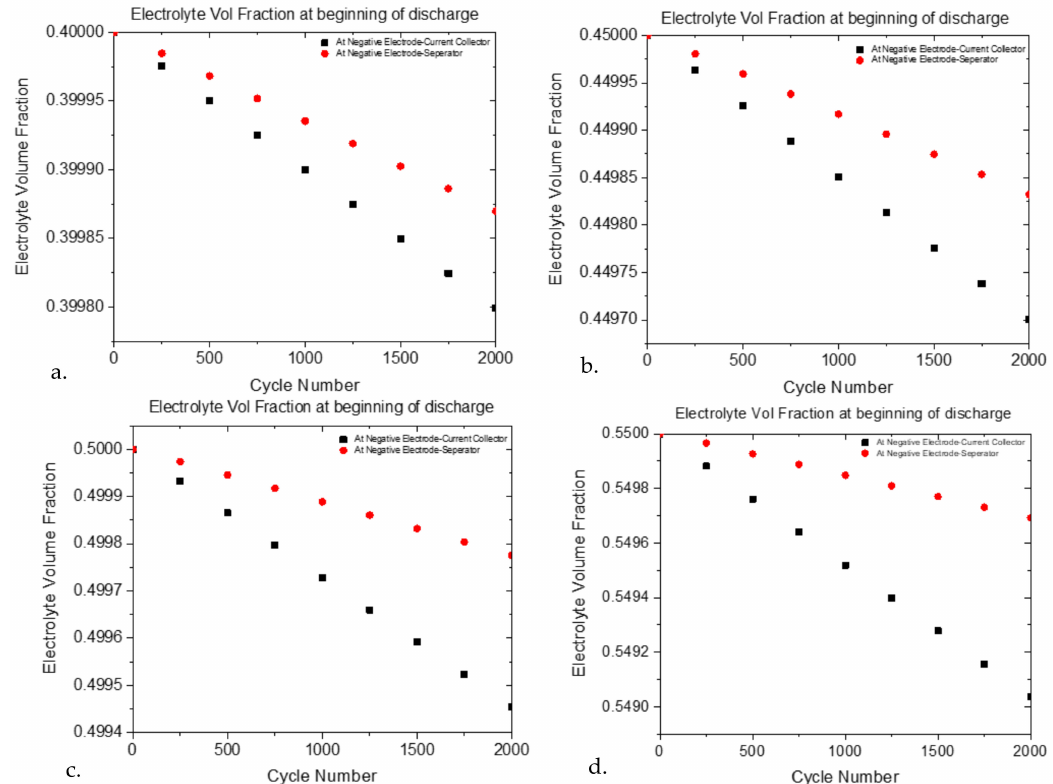
Figure 8. Simulated Electrolyte volume fraction at the two boundaries of the negative electrode at the interfaces with the current collector and the separator for porosity values of ( a ) 0.40 ( b ) 0.45 ( c ) 0.50 ( d ) 0.55.